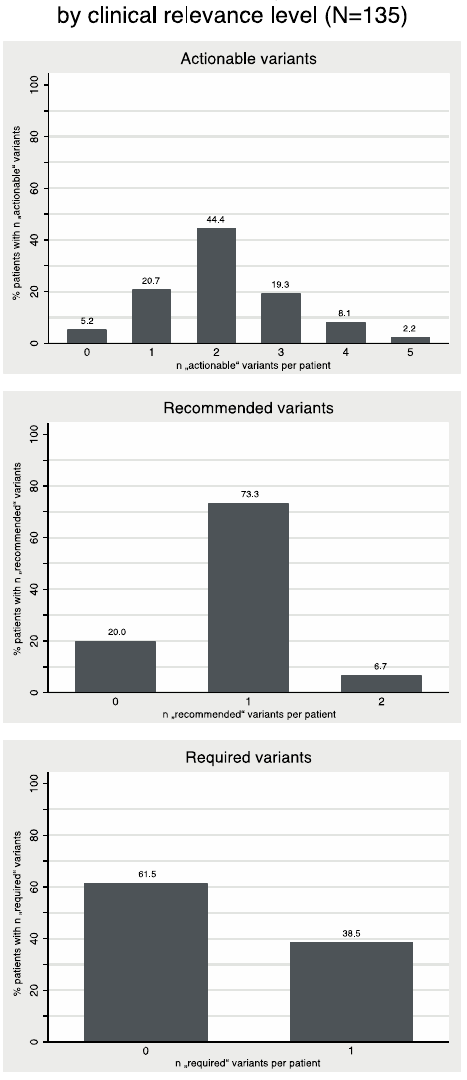
Figure 3. Distribution of number of variants per patient for “actionable”, “recommended” and “required” pharmacogenetic variants. Table 4. Detected phenotype variants and related alerts relevant for potential future medication.